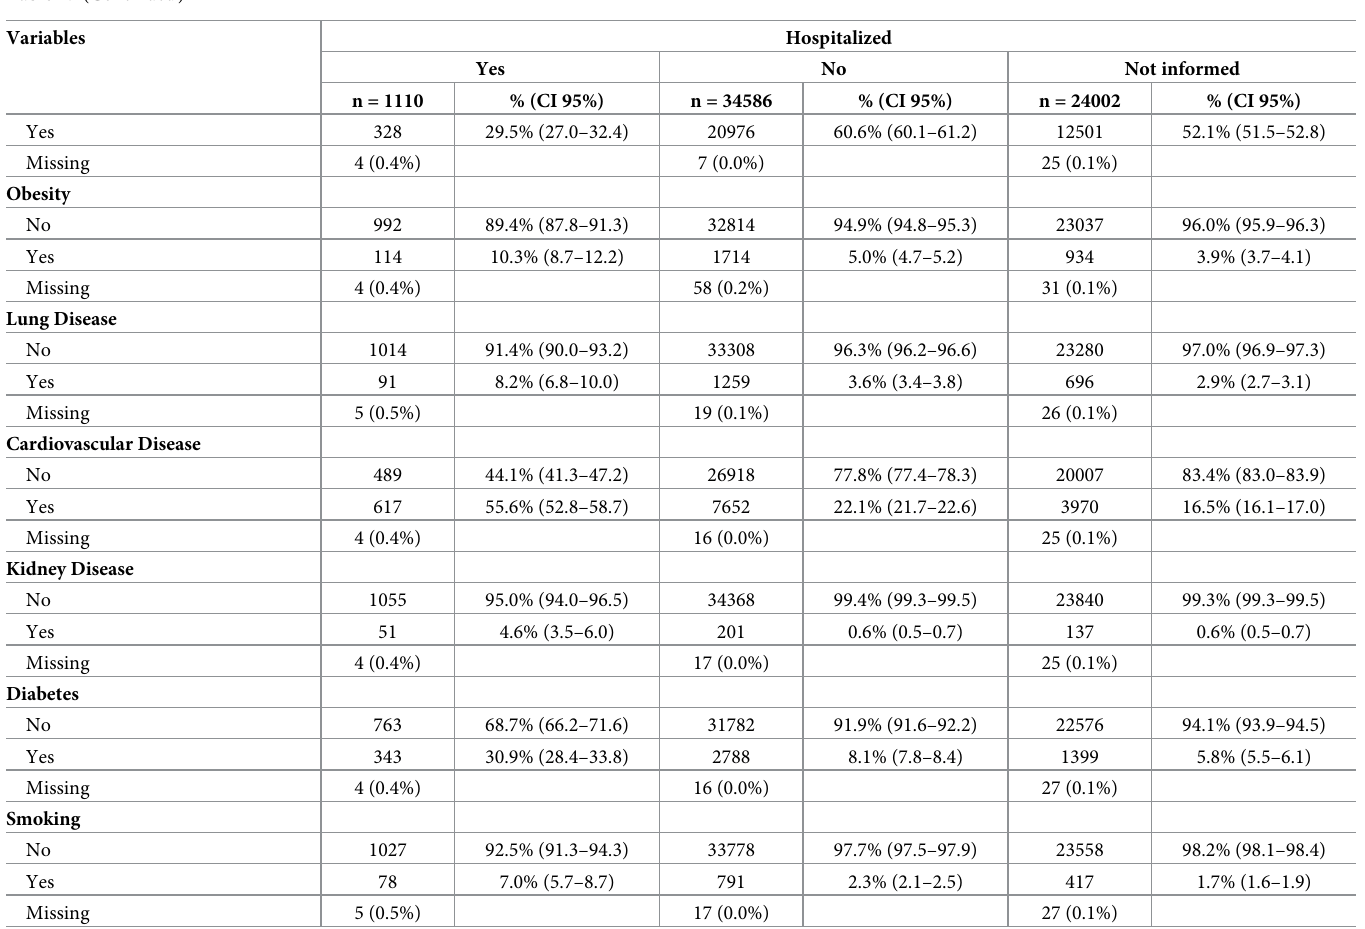
Regarding the symptoms, breathing difficulty was a symptom associated with the chance of hospitalization due to COVID-19. When compared to people who do not have this symptom, the chance of hospitalization is, respectively, 3.20 times in symptomatic cases. Symptoms such as sore throat, diarrhea and headache presented values indicating a "protective effect" for hos- pitalization by COVID-19, that is, in cases which individuals had these symptoms, there was a reduction in the chance of hospitalization of 48%, 57% and 52% compared to individuals who did not have these symptoms. Individuals who had kidney disease and diabetes have a chance of hospitalization by COVID-19, respectively, 5.32 and 2.04 times the chance of those who do not have these health problems. Table 5 presents the logistic regression model for the association of sociodemographic fac- tors and symptoms with death by COVID-19, and the data show that women are 34% less likely to evolve to death by COVID-19 when compared to men.